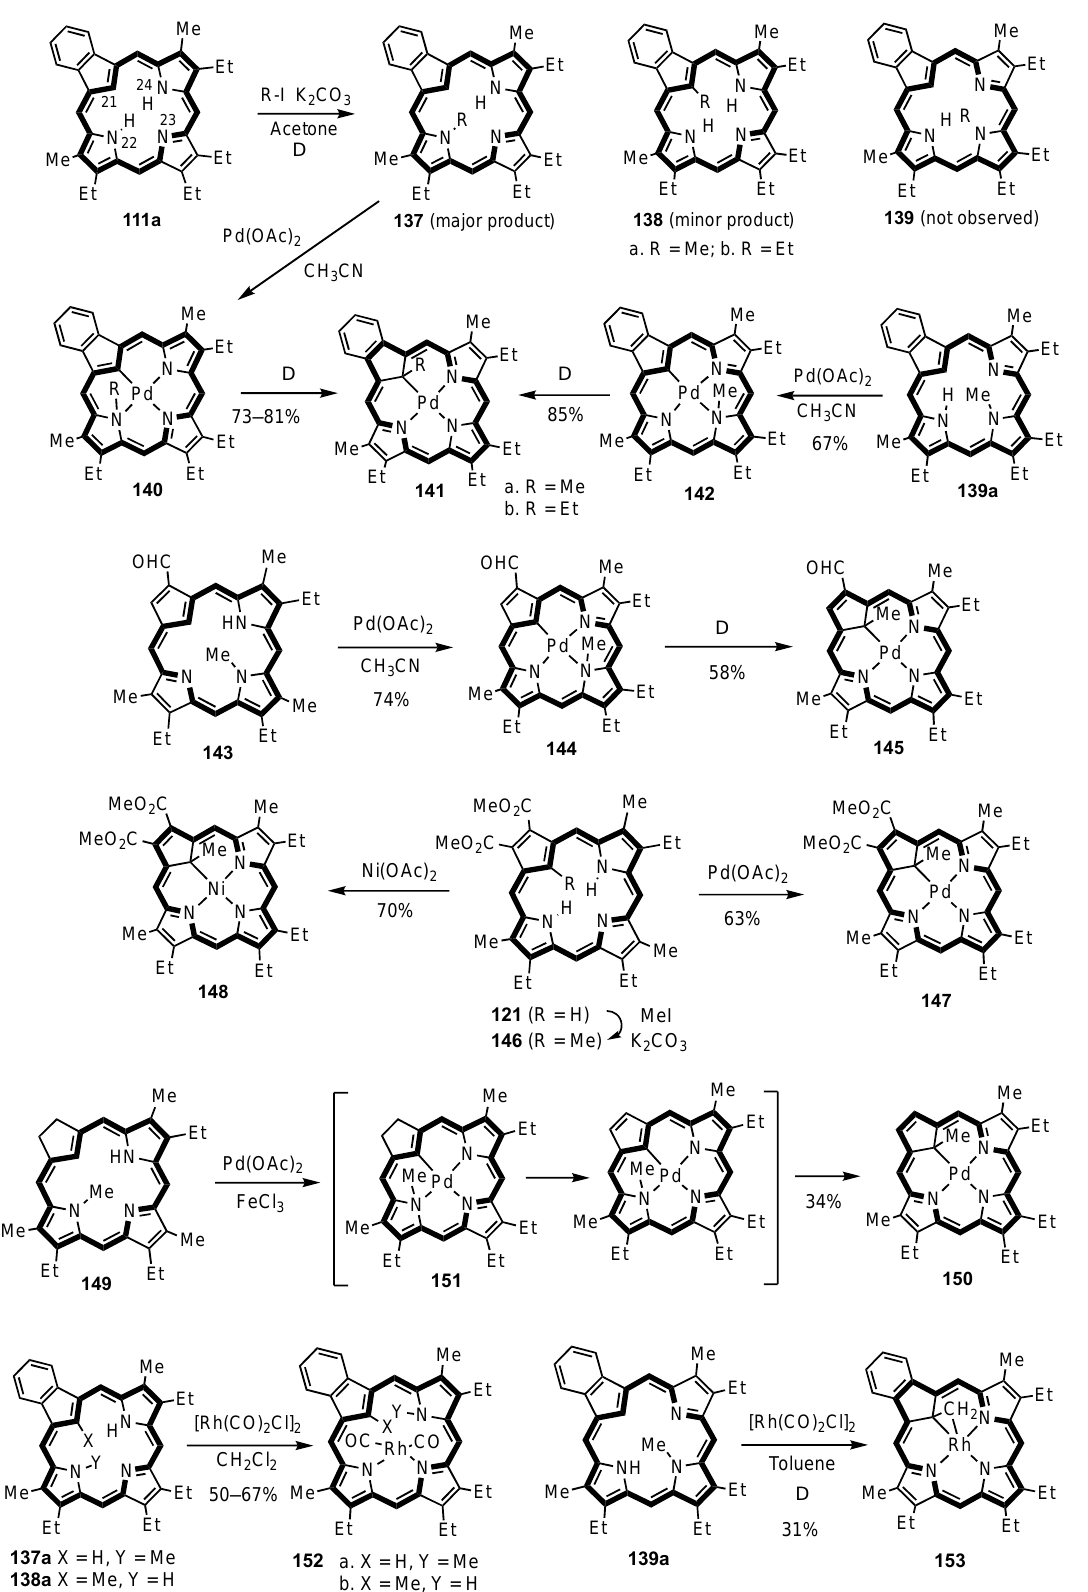
Scheme 25. Pd(II), Ni(II) and Rh complexes of internally alkylated carbaporphyrins. Carbaporphyrins favor tautomers such as 155 and 155B that have three hydrogens within the macrocyclic cavity, two of which are attached to nitrogen atoms. The